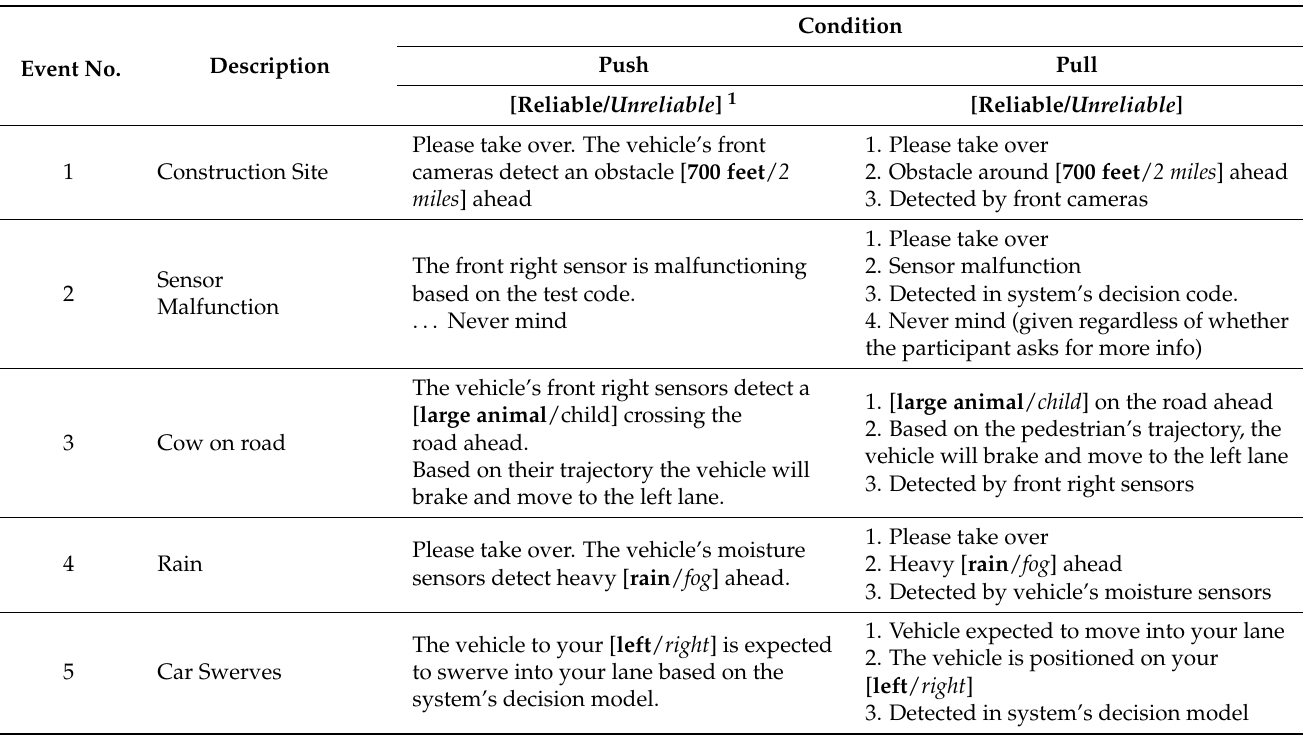
Table 2. Scenario 2 Intervention Scripts.